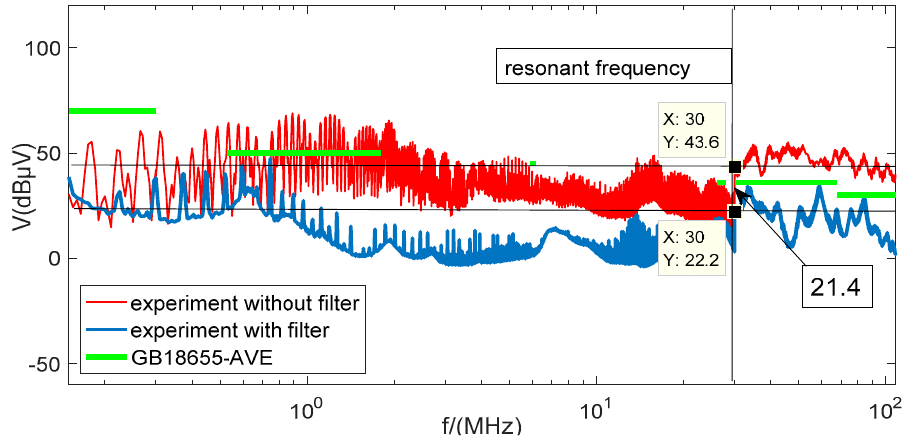
Figure 22. Comparison of experiments results.